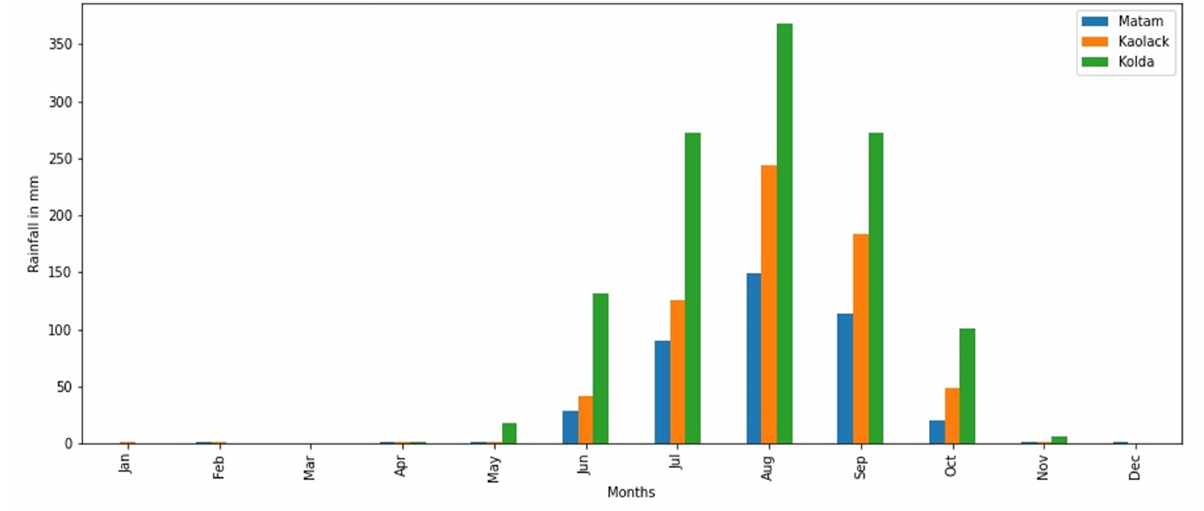
Figure 7. Monthly average rainfall variation for Matam, Kaolack and Kolda (1982–2020).